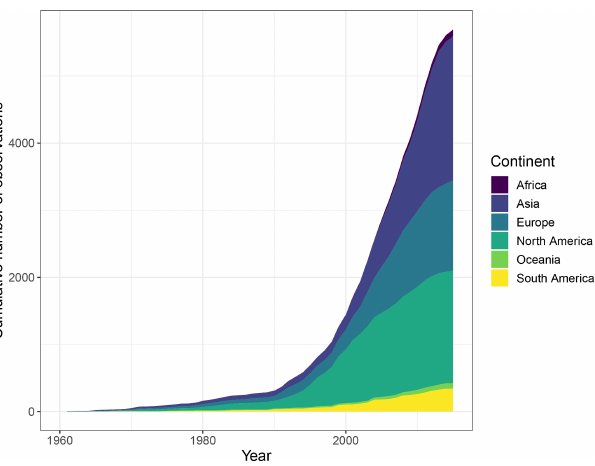
Figure 3. Number of published soil carbon dioxide flux obser- vations (cumulative observations per million square kilometers) in each region. An observation indicates a set of measurements conducted in a site during a certain period. Data source: Jian et al. (2021).